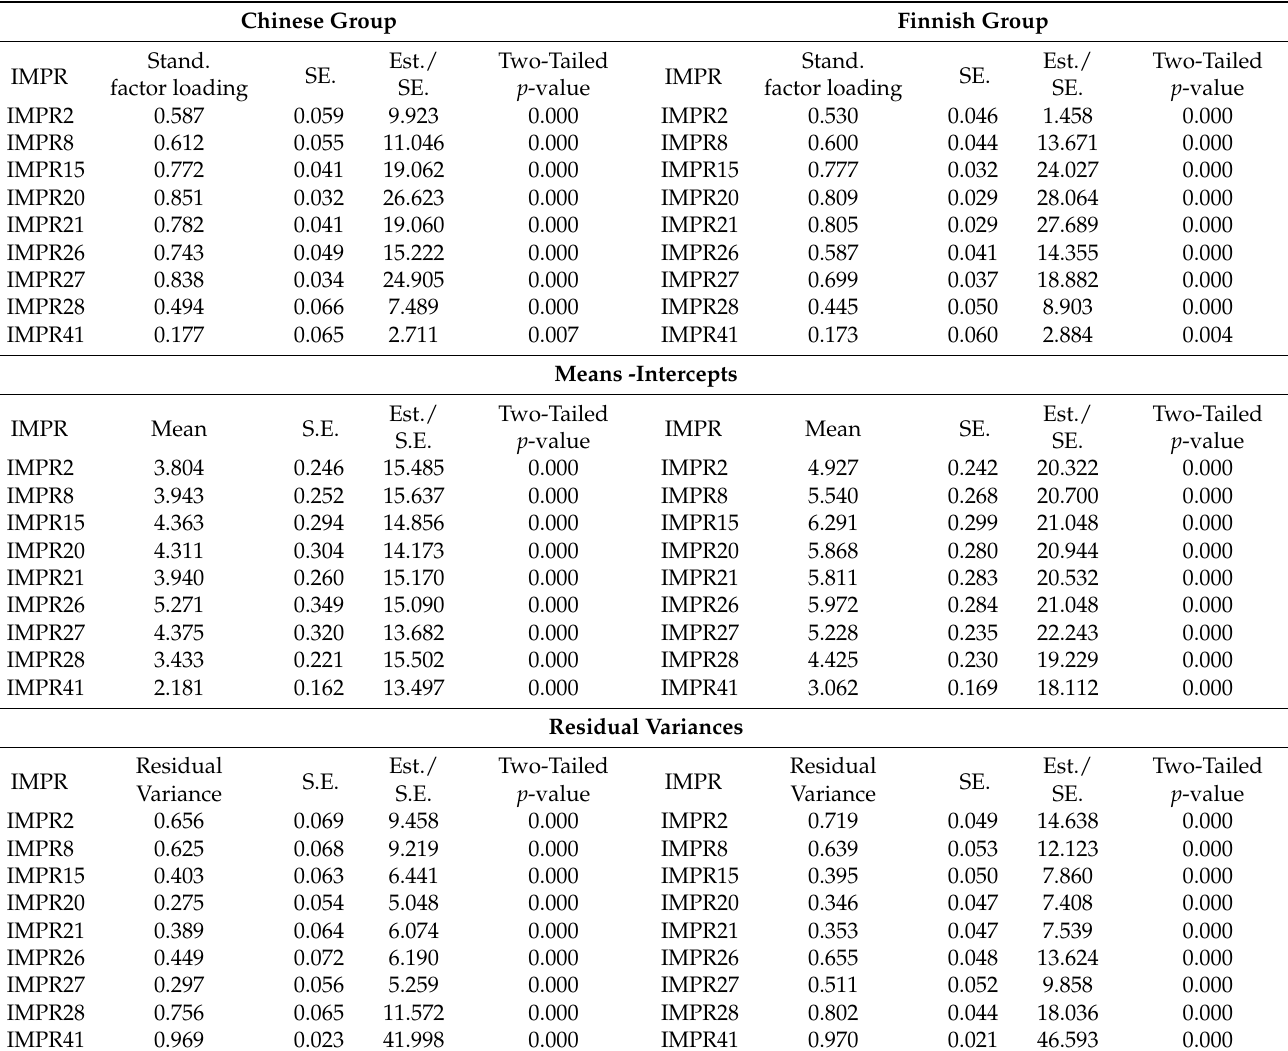
Table 7. Improvement/students—strong factorial